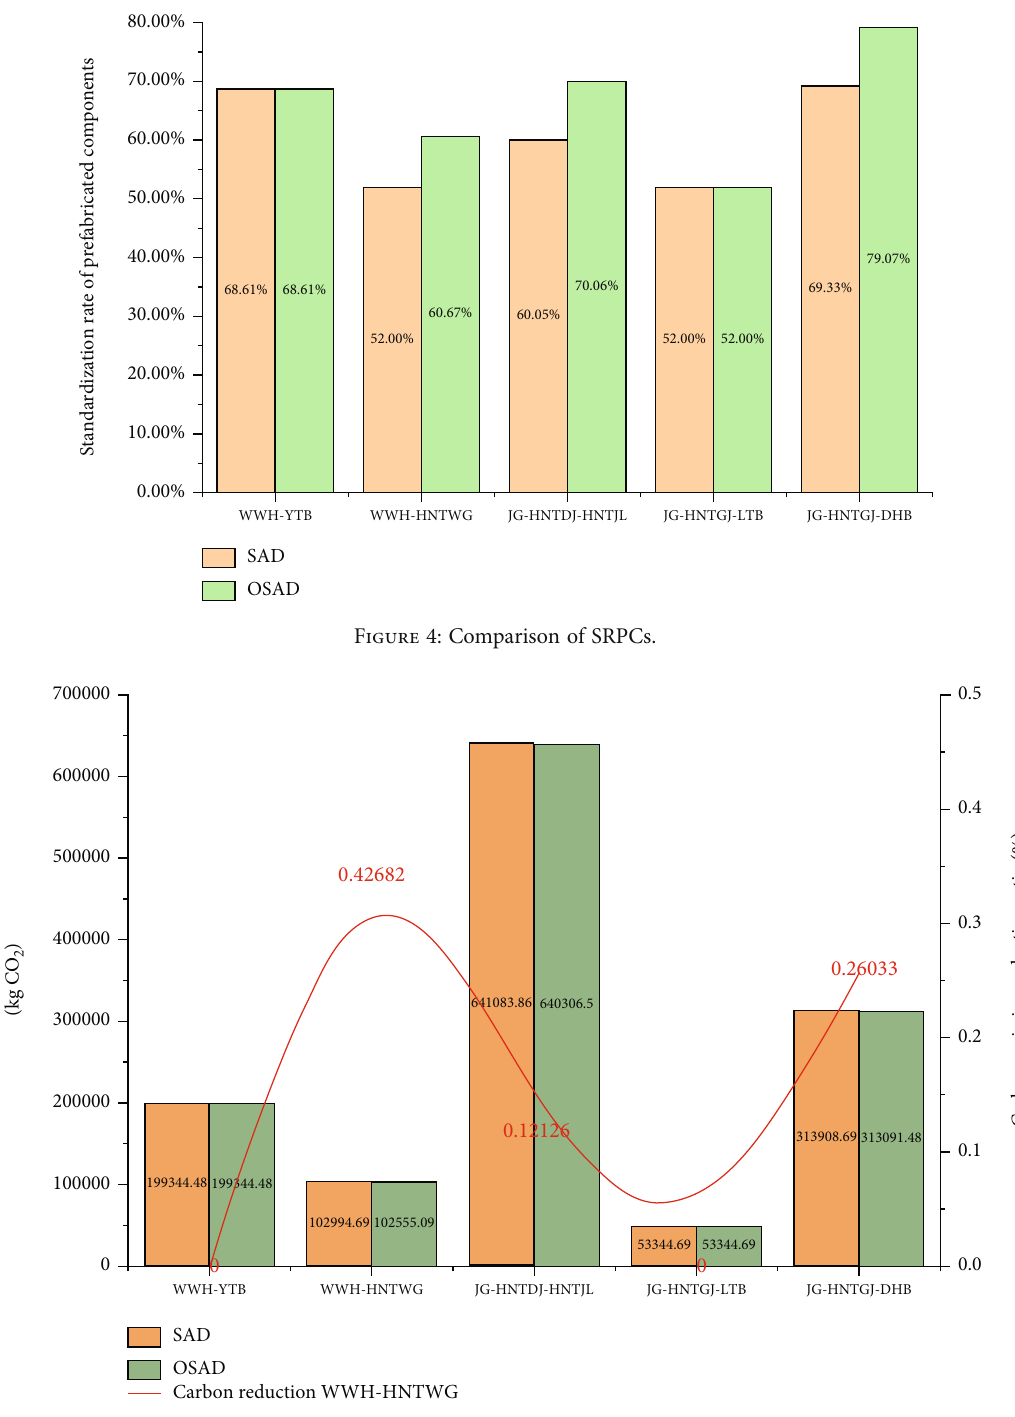
Figure 5: Comparison of carbon emissions for prefabricated components.